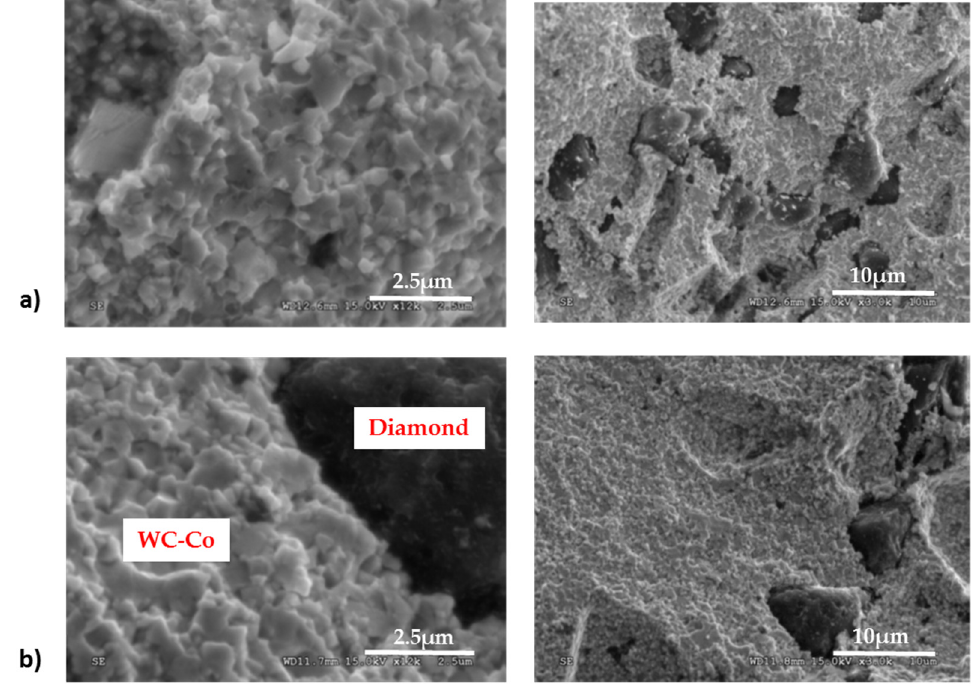
Figure 8. SEM images of WC-Co/diamond composites ( a ) 8–10 µm, ( b ) 16–20 µm.